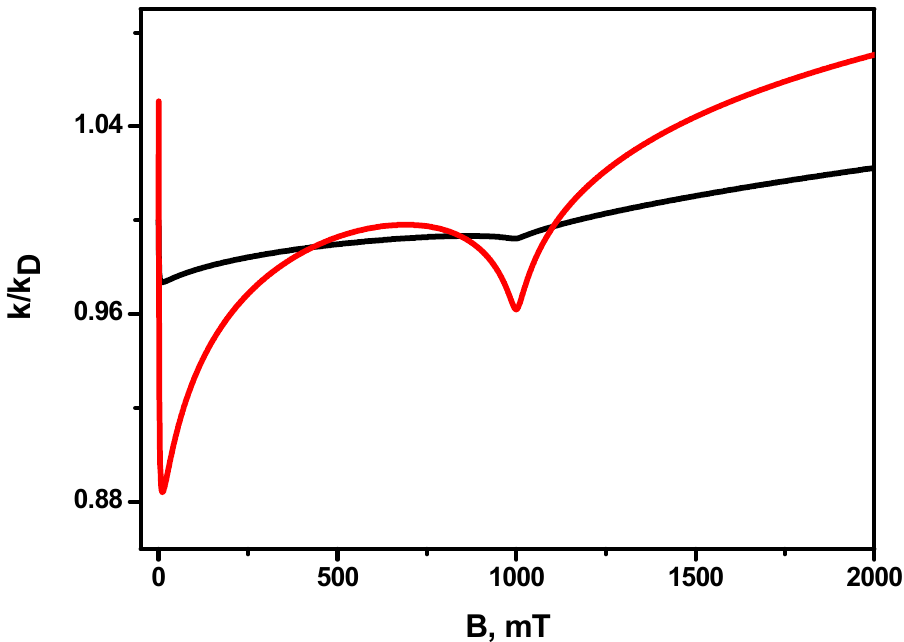
Figure 5. Magnetic field effect k ( B ) / k ( B = 0 ) for equal hyperfine constants a 1 = a 2 = 0.5 mT in radicals. Black line D = 2.0 · 10 − 5 cm 2 as in Figure 1.